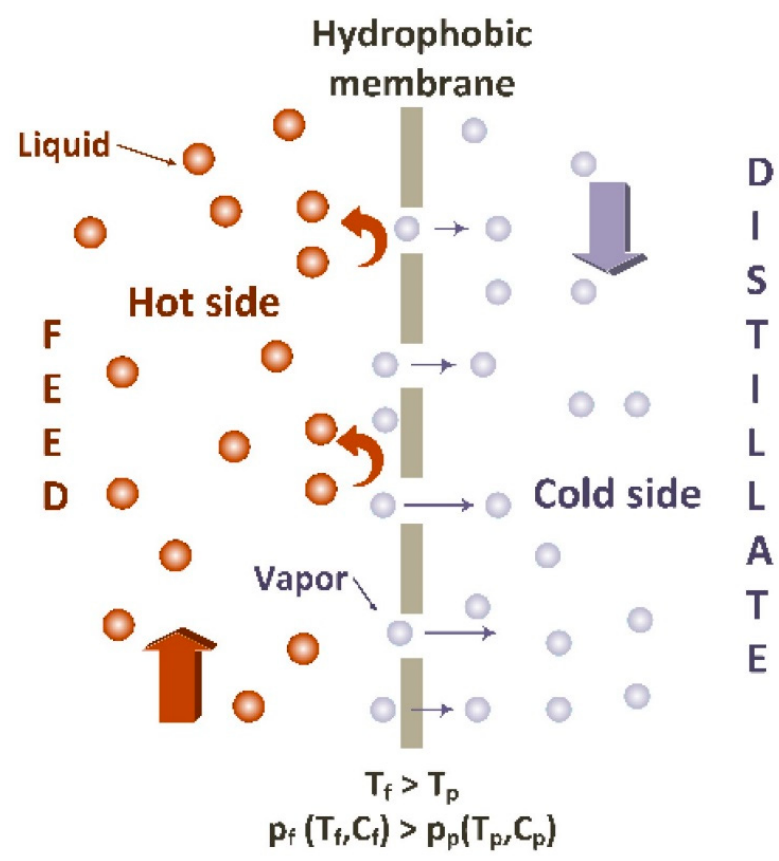
Figure 1. Membrane distillation (MD) principles [5].